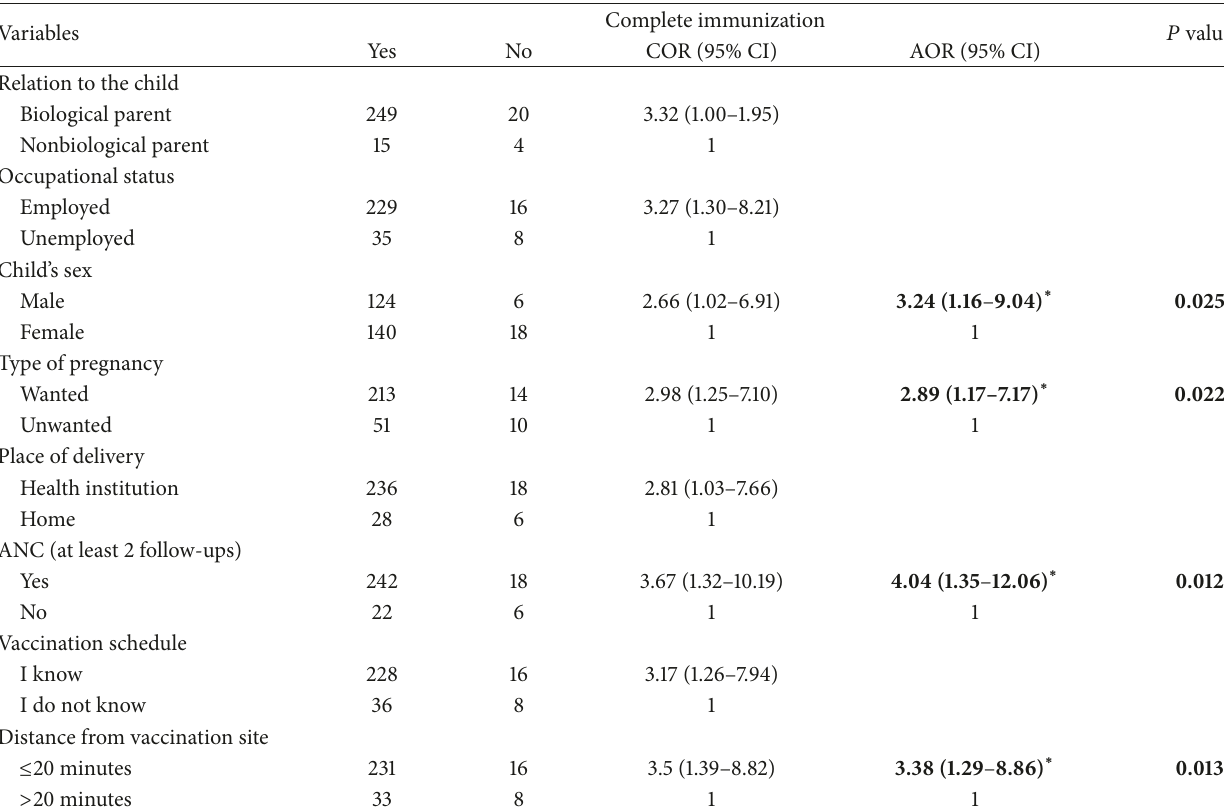
Table 5: Factors associated with complete immunization of children aged 12–23 months in Debre Markos town, Amhara Regional State, North West Ethiopia, September 2016. ( 𝑁 = 288